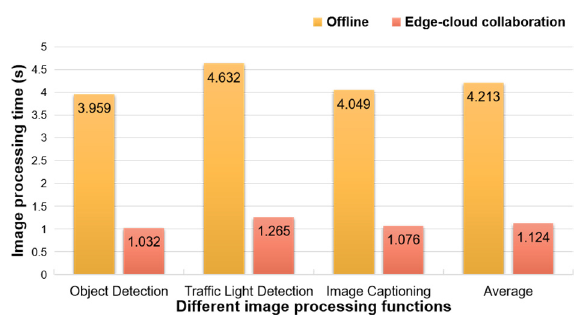
Figure 23. Comparison of the image processing time of offline and edge-cloud collaboration.